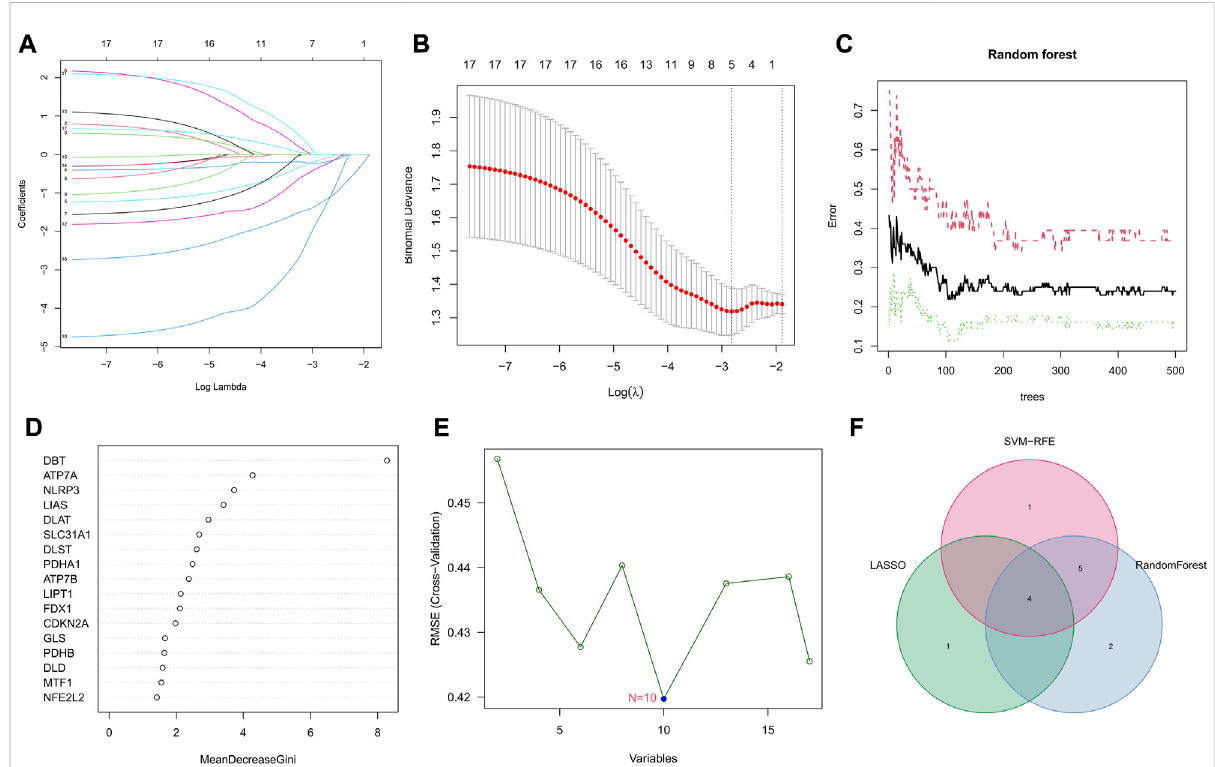
FIGURE 3 Selection of signature genes among genes associated with Parkinson ’ s onset and cuprotosis. (A) Ten cross-validations of adjusted parameter selection in the LASSO model. Each curve corresponds to one gene. (B) LASSO coef fi cient analysis. Vertical dashed lines are plotted at the best lambda. (C) Relationship between the number of random forest trees and error rates. (D) Ranking of the relative importance of genes. (E) SVM-RFE algorithm for feature gene selection. (F) Venn diagram showing the feature genes shared by LASSO, random forest, and SVM-RFE